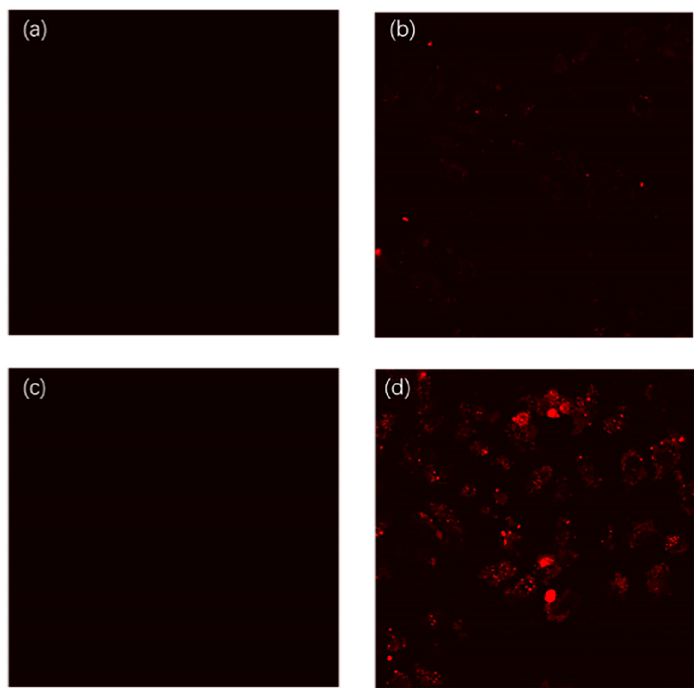
Figure 7. Fluorescence images of TAM-PEP (R8)/GO mixture in Hela cells and Bcl-xL overexpression cells. ( a ) Fluorescence images of only Hela cells; ( b ) Fluorescence images of TAM-PEP (R8)/GO mixture in Hela cells; ( c ) Fluorescence images of Bcl-xL overexpression cells; ( d ) Fluorescence images of TAM-PEP (R8)/GO mixture in Bcl-xL overexpression cells. Experiment conditions: TAM-R8-PEP: 1 μ M; GO: 5 μ g/mL; Excitation: 559 nm.